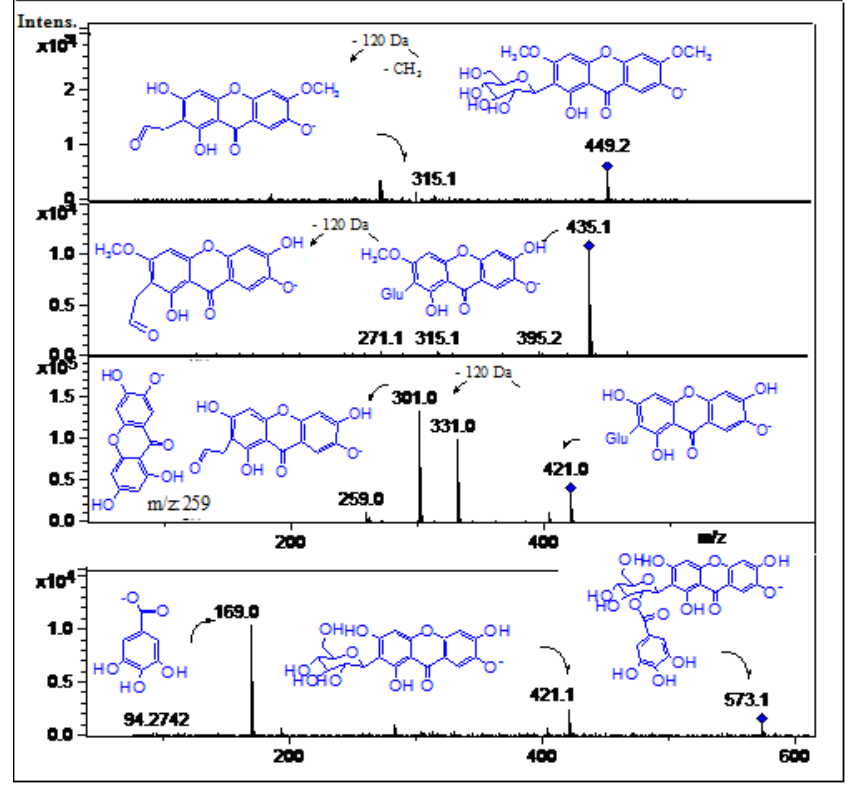
Figure 6. Structures, fragmentations, full ESI-MS and MS-MS spectra of peaks 10 and 12 – 14